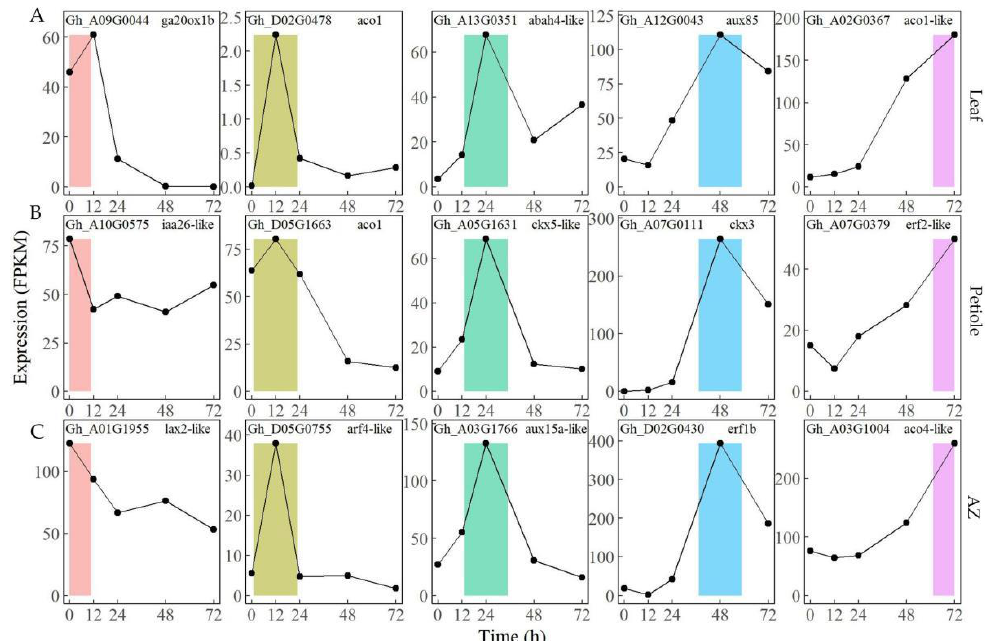
Figure 4. The expression (FPKM) of DEGs involved in plant hormone pathway upon TDZ treatment in leaf ( A ), petiole ( B ), and AZ ( C ) at indicated time points. The DEGs of 0, 12, 24, 48, and 72 h are shown in pink, yellow-green, green, blue, and purple, respectively.